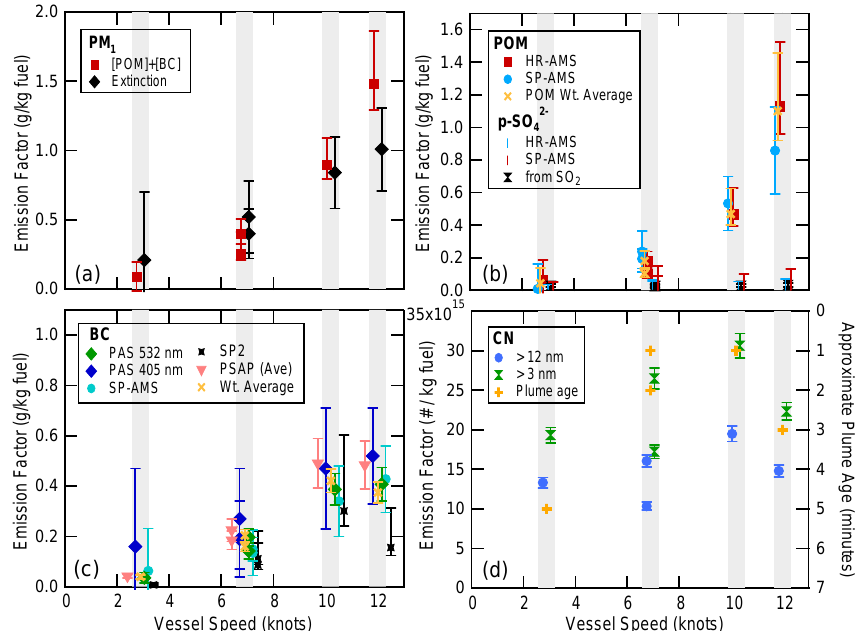
Fig. 1. Measured mass or number-based emissions factors (in per kg fuel) for (a) total sub-micron particulate matter, (b) POM or particulate − SO 2 , (c) BC, either equivalent BC (PAS and PSAP) or refractory BC (SP2 and SP-AMS) and (d) condensation nuclei and approximate 4 plume age. Values have been offset from the central speed, indicated in gray, for clarity. For sulfate, error bars shown with no data point indicate the plume-specific detection limit for that